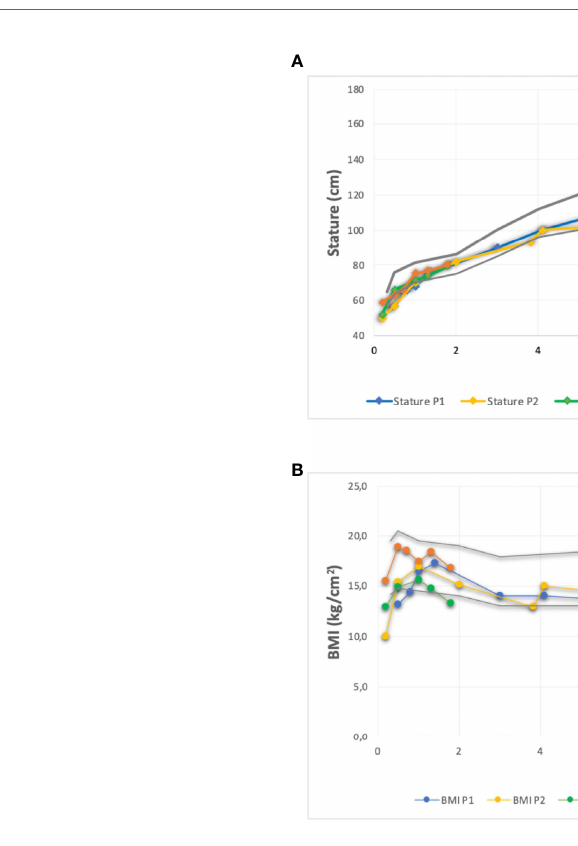
FIGURE 1 | Comparison of stature (A) and (B) Body Mass Index evolution of four patient using standard deviation scores according to WHO growth charts. BMI, Body M ass Index; P, patient, SD, Score Deviation.